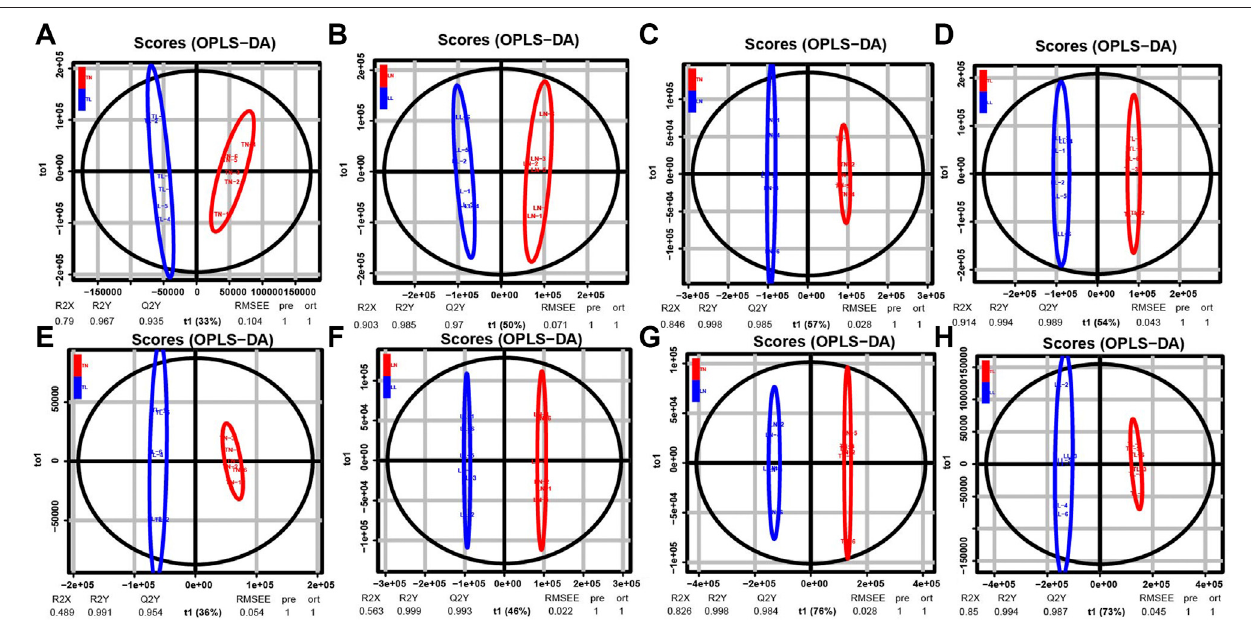
FIGURE 3 | OPLS-DA scores of polar components of ATII cells metabolic pro fi ling analysis. The OPLS-DA models were derived from the LC-MS metabolomic pro fi les among four groups. Both negative mode (NEG) are shown for (A – D) , and positive (POS) models are shown for (E – H) as